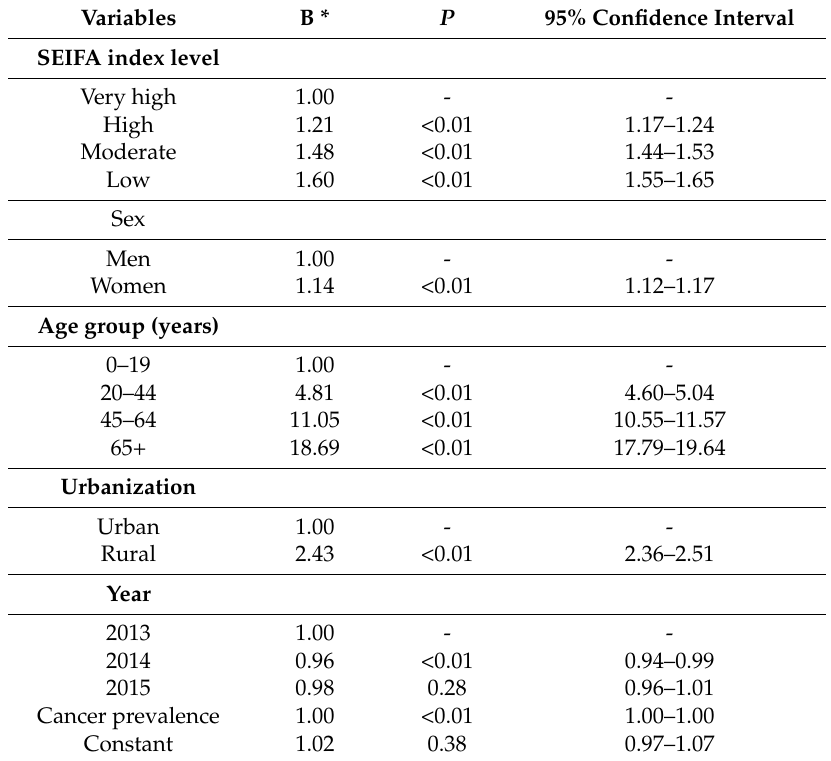
Table 4. Multivariable model reflecting factors associated with quantity of standardized doses dispensed. Variables B * P 95% Confidence Interval SEIFA index